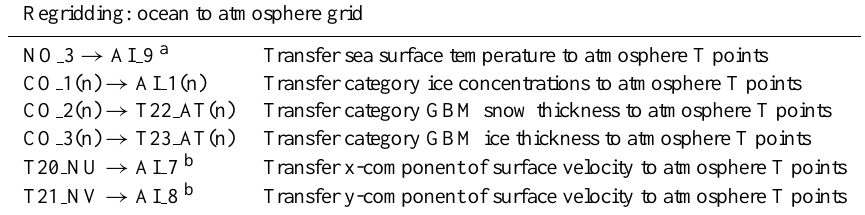
Table 2d. Details of regridding the ocean/ice fields onto the atmosphere grid in Fig. 5. These manipulations are carried out by OASIS itself. “n” is the ice thickness category